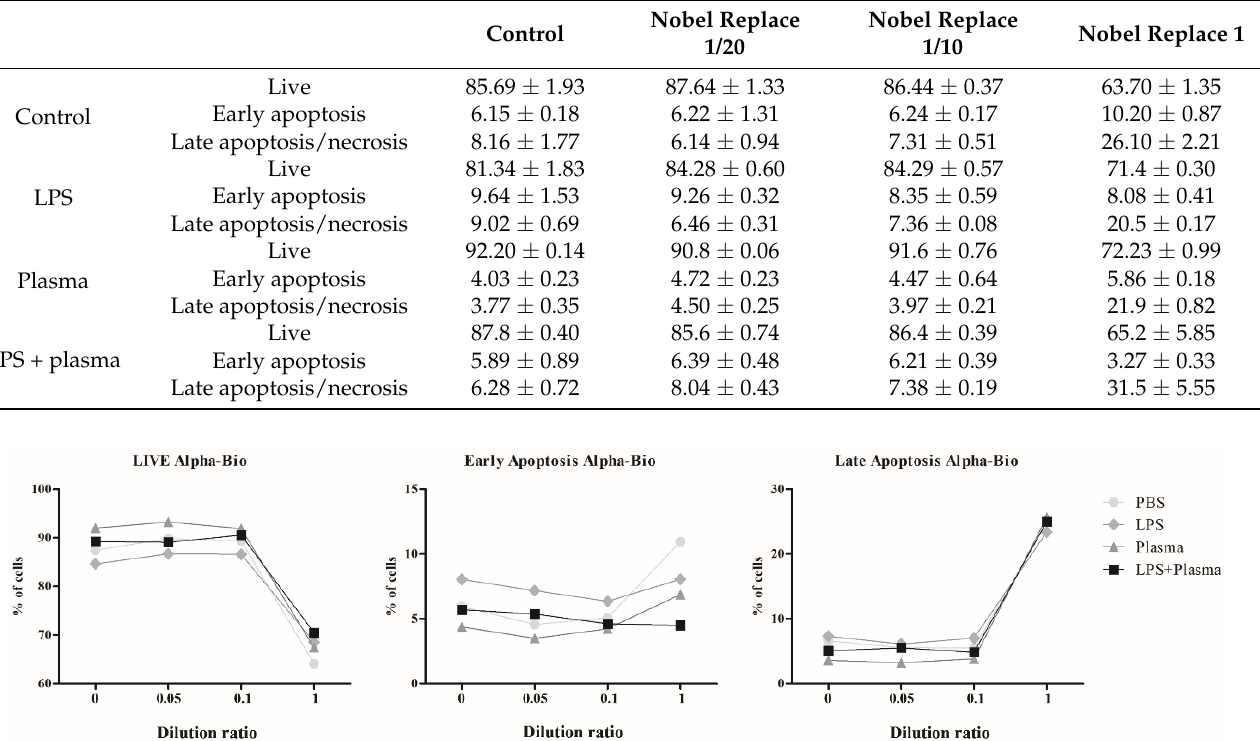
Table 5. Analysis of the viability of ТНР- 1 cells after 24 h of incubation with NSMP from the Nobel Replace system.